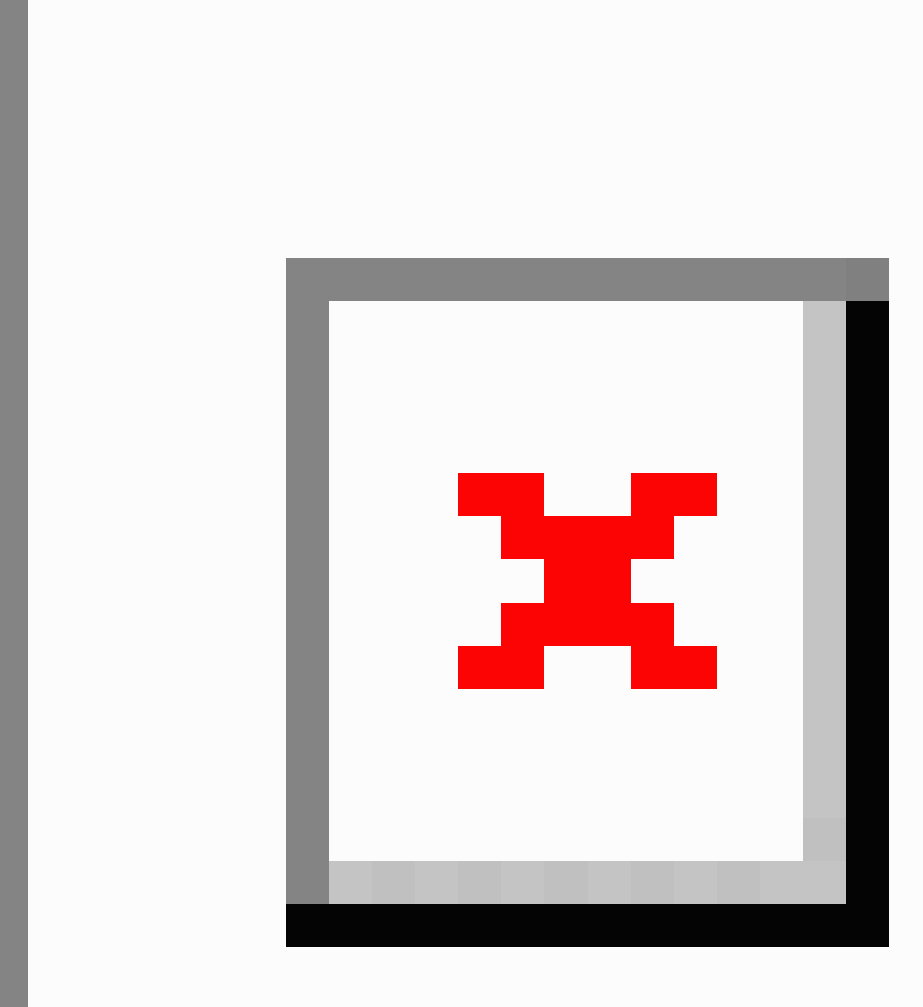
Figure 2. My PearlPoint